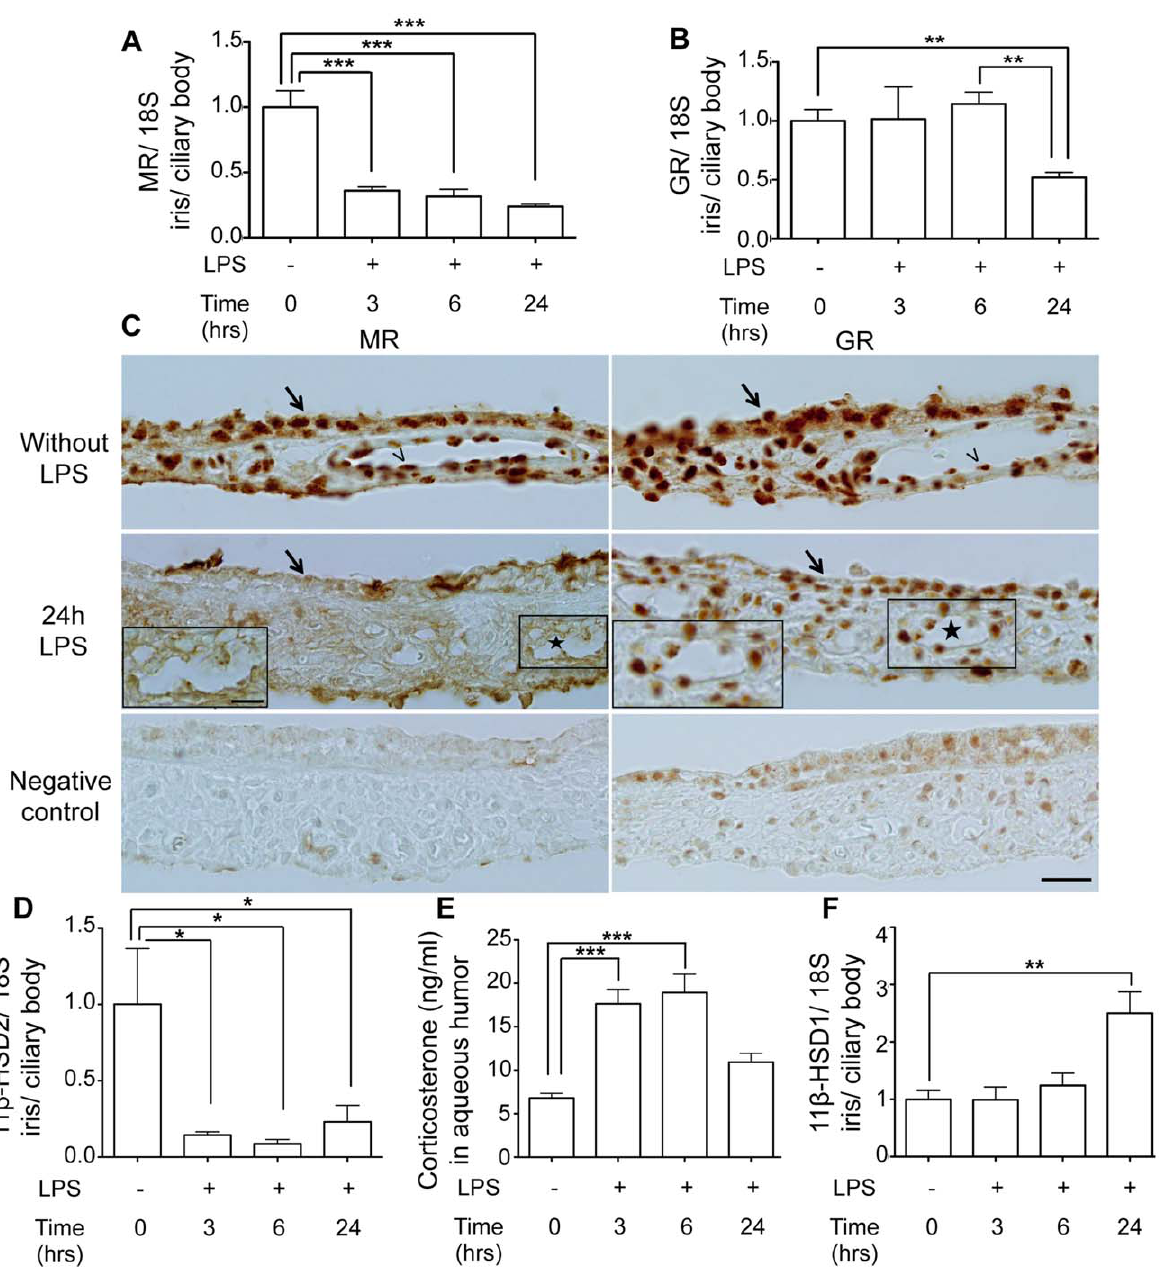
Figure 1. MR, GR, 11 b -HSD1, 11 b -HSD2 expression in iris/ciliary body and corticosterone concentration in aqueous humor during EIU. A–B: Time-course of MR (A) and GR (B) mRNA expression (real-time PCR). After LPS injection, down-regulation of GR was observed only at 24 hours, whilst MR expression was down-regulated already at 3 hours. The 18S was used as housekeeping gene. Results in EIU are relative to those without LPS injection. Data are means 6 SEM; n=6 rats per conditions; **p , 0.01, ***p , 0.001. C: Immunohistochemistry of MR and GR in iris sections. In normal iris rat, MR and GR are localized in the nuclei of the iris epithelial cells (arrow), endothelial cells (arrowhead) and probably in other resident cells of the iris stroma. Twenty-four hours after LPS injection, MR and GR expression signals were reduced in uveitis eyes (star: vessels). Negative controls are signals yielded in the absence of primary antibody. Scale bar=40 m m; 20 m m for insert. D–F: Time-course of 11 b -HSD2 (D), 11 b - HSD1 (F) expression (real-time PCR) and corticosterone concentration in aqueous humor (E). LPS injection induced an early (3 hours) down-regulation of 11 b -HSD2 transcripts and a late up-regulation of 11 b -HSD1 transcripts at 24 hours compared to rats without LPS injection. The 18S was used as housekeeping gene. Results in EIU are relative to those without LPS injection. Corticosterone concentration in aqueous humor increases at 3 and 6 hours after LPS injection. Data are means 6 SEM; n=6 rats per conditions; *p , 0.05, **p , 0.01, ***p , 0.001. doi:10.1371/journal.pone.0049036.g001 (i.e. 6 hours), aldosterone significantly decreased several pro- (Fig. 3A). At 24 hours the aldosterone-induced reduction of TNF- a , IFN- c and MIP-1 a was sustained (Fig. 3B). There was no inflammatory mediators: TNF- a , IFN- c , IL-2, MCP-1, MIP-1 a as compared to vehicle injection while IL-6 levels were not modified significant effect on other tested cytokines (IL-1 b , IL-18, IL-4, IL-